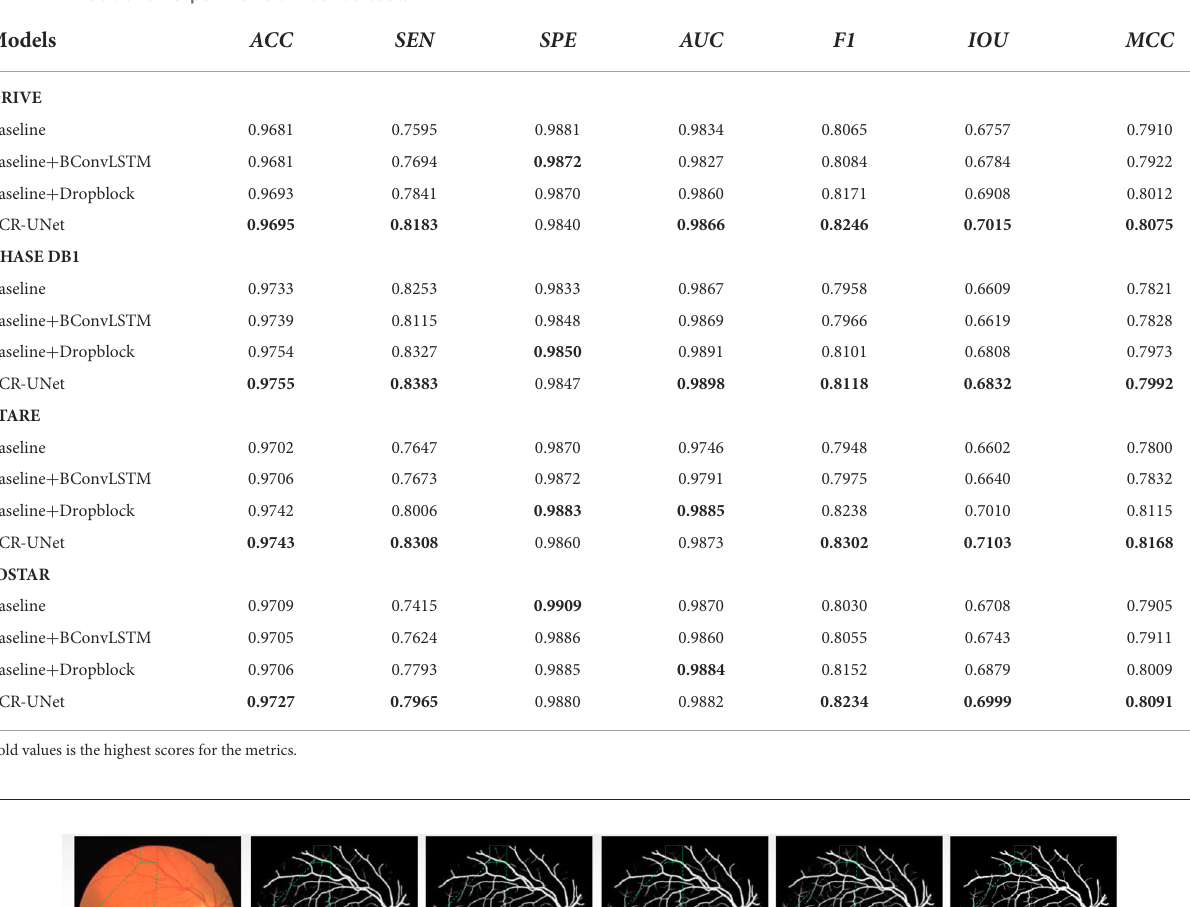
TABLE 2 The ablation experiments on four